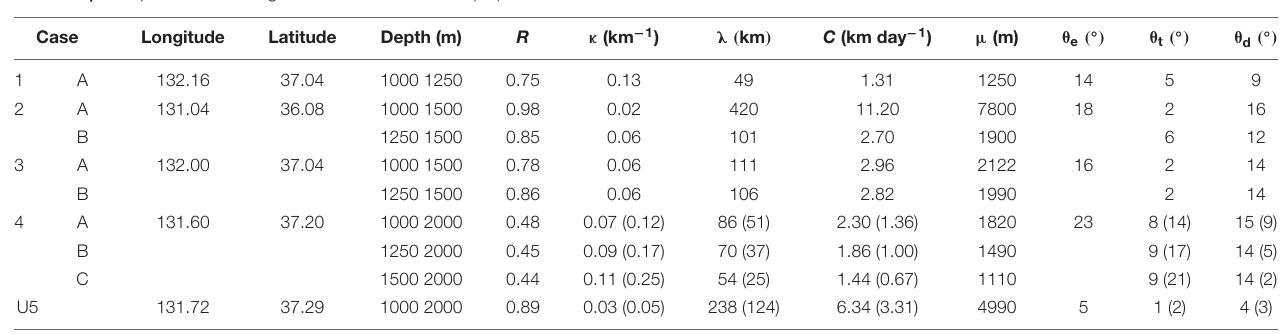
R is the ratio of the spectra of U r components between two different depths, κ is the horizontal wavenumber, λ is the wavelength, C is the phase velocity, and µ is vertical trapping scale. The estimated angle ( θ e ) of the principle major axis at the lower depth and the angles ( θ t ) predicted by the linear TRW dispersion relation are measured clockwise from the downslope for the period band of 30–50 days. The difference between the angles ( θ d ) is measured. θ t and θ d are also measured using the mean buoyancy frequency from the observed CTD data for Case 4 in parentheses.